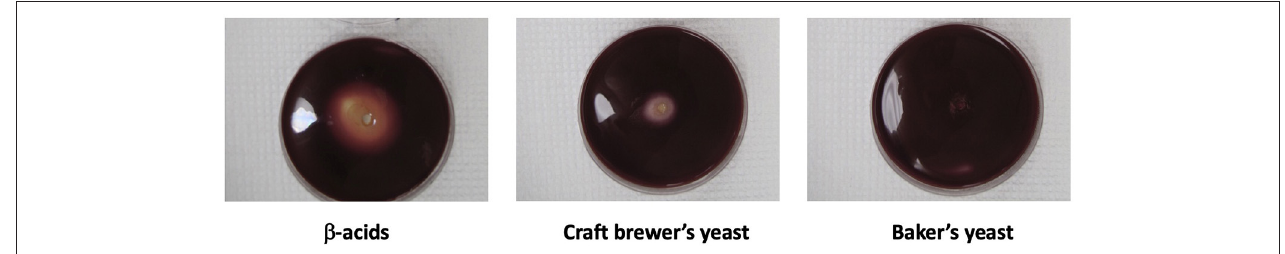
FIGURE 4 | Acetoanaerobium sticklandii SR , a hyper ammonia-producing bacterium isolated from the bovine rumen, was inoculated into molten agar and grown anaerobically within the agar. Pasteurized yeast slurry, equivalent to 5–10mg dry yeast, was placed in center wells. Bacteria were stained with the vital dye, Tetrazolium Red. β -Acids, 30 mg/ml, were a positive control.